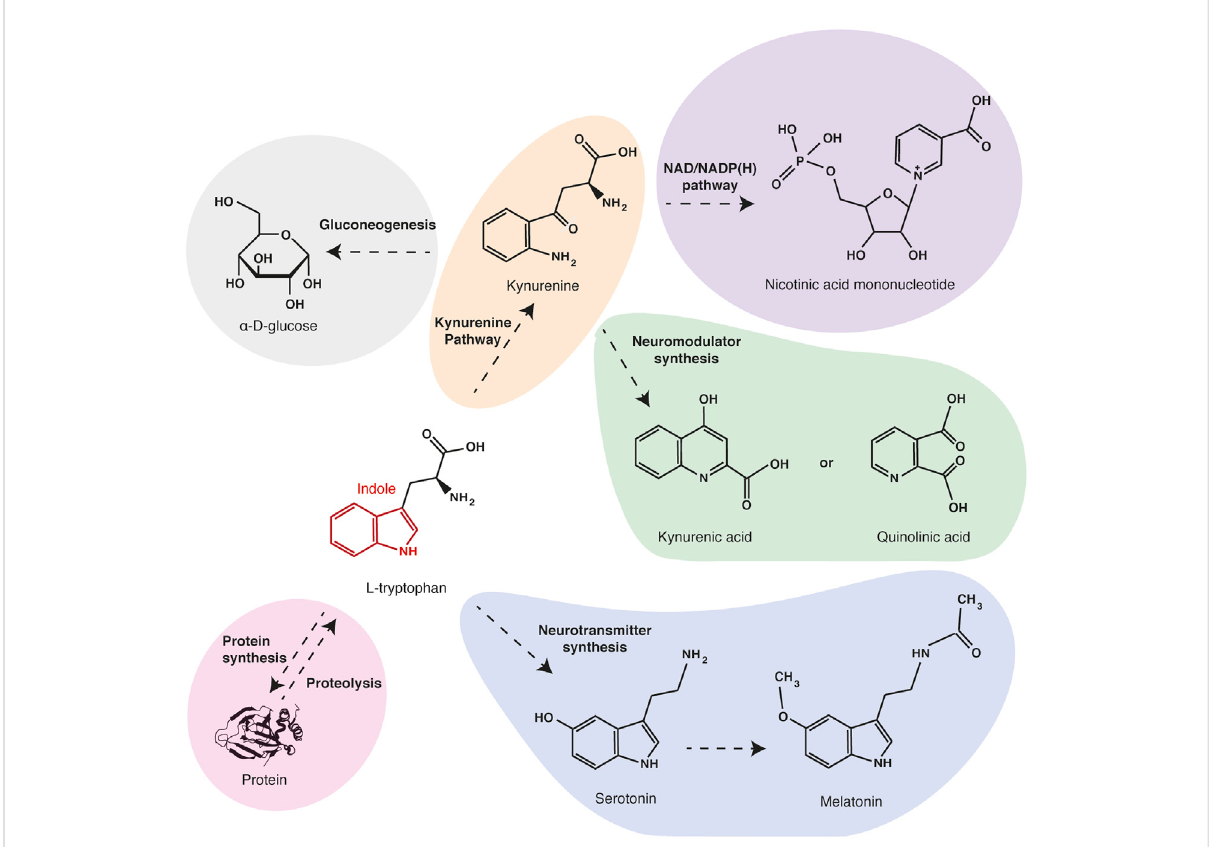
FIGURE 1 Maintryptophanmetabolitesandfunctions.Tryptophanisoneofthetwentyproteinogenicaminoacids.Besidesbeingaproteinbuildingblock, tryptophan can be oxidized in kynurenine (orange), the precursor of electron transporters NAD/NADPH (purple) and of neuromodulators quinolinic acid and kynurenic acid (green). Through the same pathway, tryptophan can also be metabolized in alanine and serve as a substrate for gluconeogenesis (grey). Alternatively, tryptophan can be metabolized in neurotransmitters serotonin and melatonin